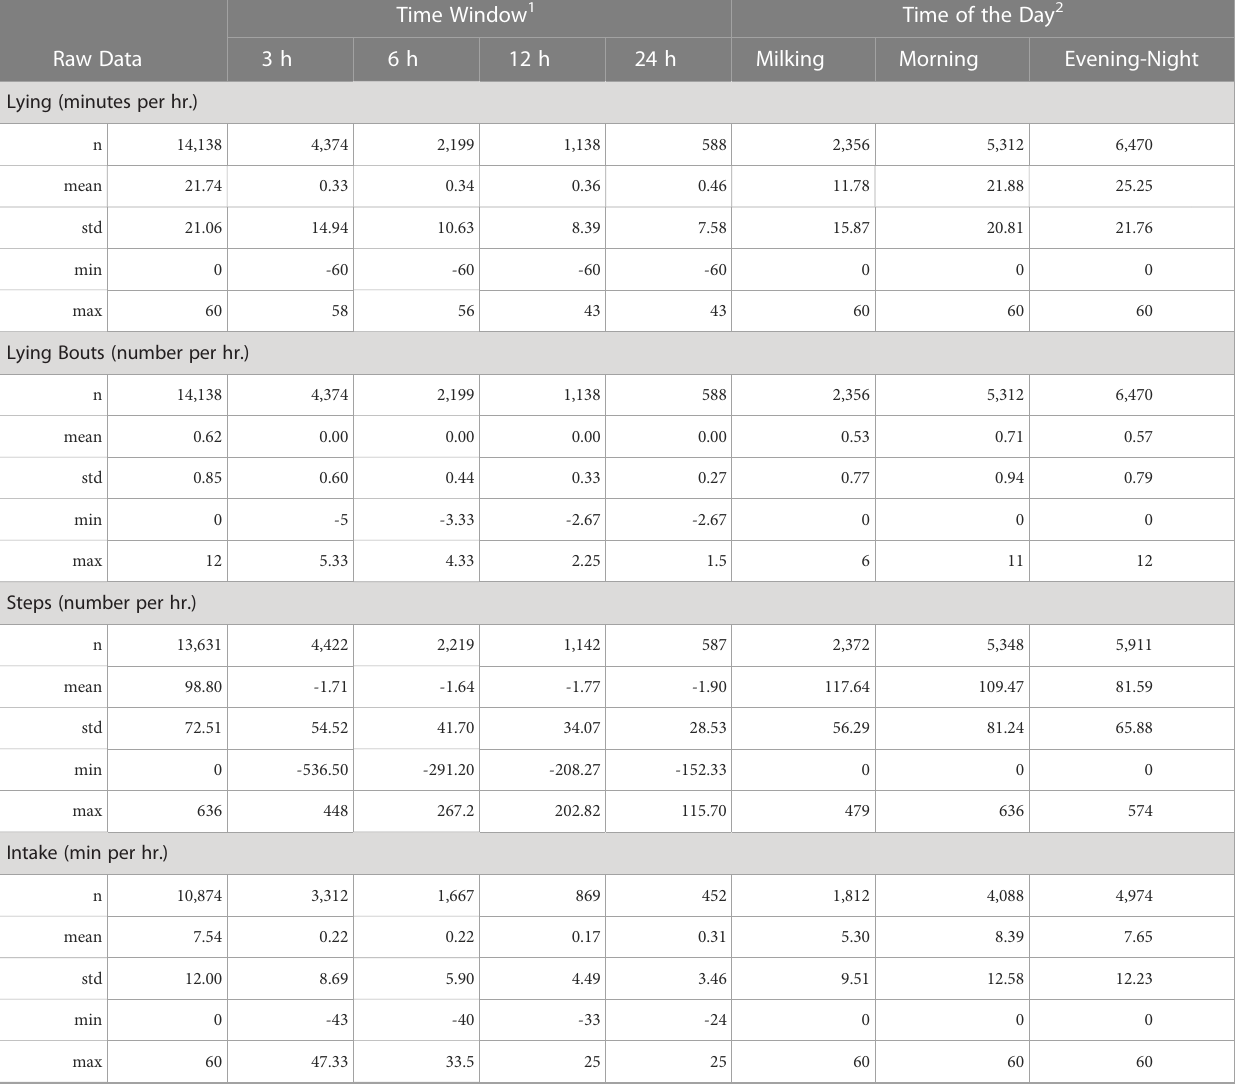
TABLE 2 Descriptive statistics for the fi ve behavior variables measured with a leg-attached 3-axis accelerometer (Trackacow, ENGS, Hampshire, UK).